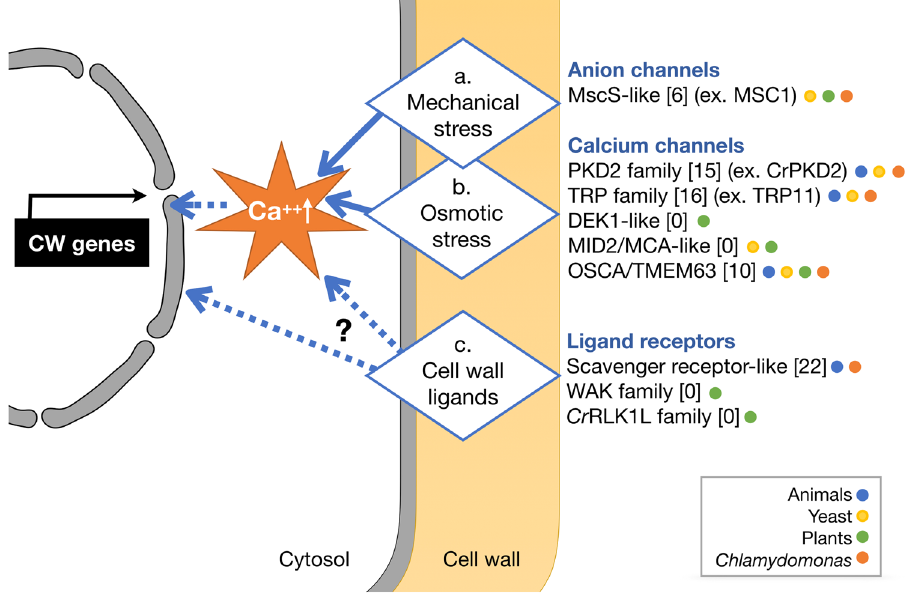
Figure 7. A model of cell wall integrity signaling in C . reinhardtii . This model illustrates three sensing mechanisms that may crosstalk via Ca ++ oscillation and/or protein phosphorylation for rapid upregulation of CW genes upon cell removal by g-lysin treatment. Solid arrows indicate signaling mechanisms with experimental evidence. Dashed arrows depict putative signaling mechanisms. A sensory role of mechanical and osmotic stresses is so far reported for mechanosensitive channels in six different families ( a , b ). Three protein families of known or putative receptors sensing cell wall-associated ligands may be involved in CW gene regulation directly or indirectly via mechanosensitive channel-dependent signaling ( c ). Numbers in brackets indicate the number of candidate genes found in the C . reinhardtii genome. Functionally characterized proteins of C . reinhardtii are given as examples. Colored dots indicate which organisms possess genes for the given family. MscS, mechanosensitive channel of small conductance; PKD2, polycystic kidney disease 2; TRP, transient receptor potential; MCA, mid1 -complementing activity; WAKs, wall-associated kinase; Cr RLK1L, Catharanthus roseus receptor-like kinase 1-like